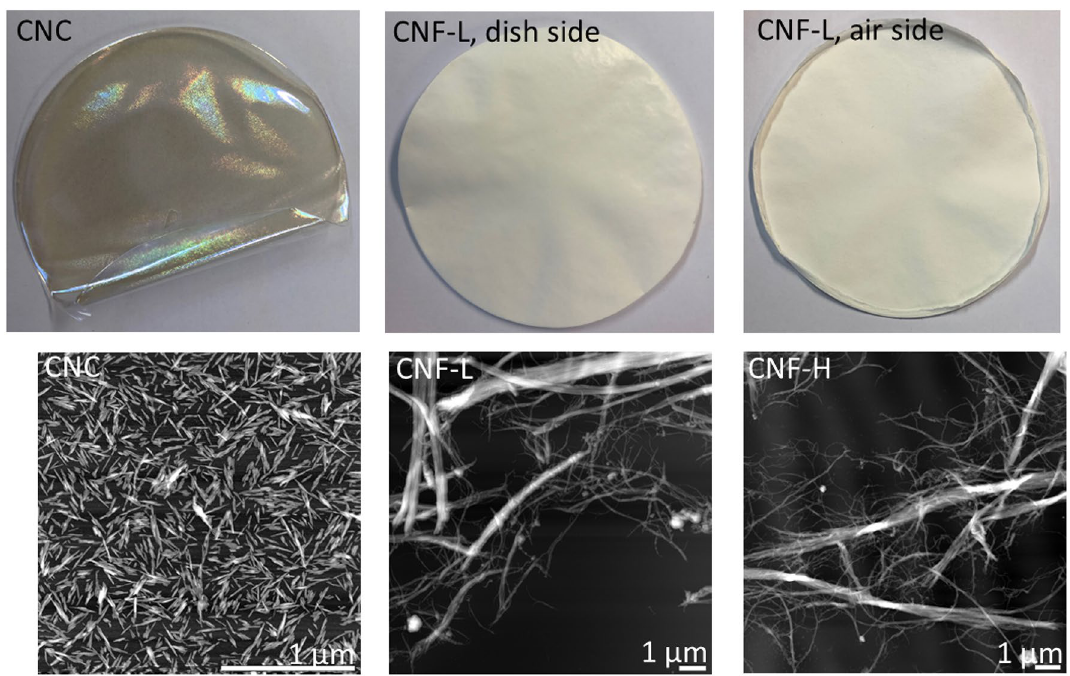
Figure 3. Nanocellulose films used for swelling tests in this paper. Bottom row: AFM micrographs. AFM of CNCs are adapted from Torstensen et al. 46 (with premission from